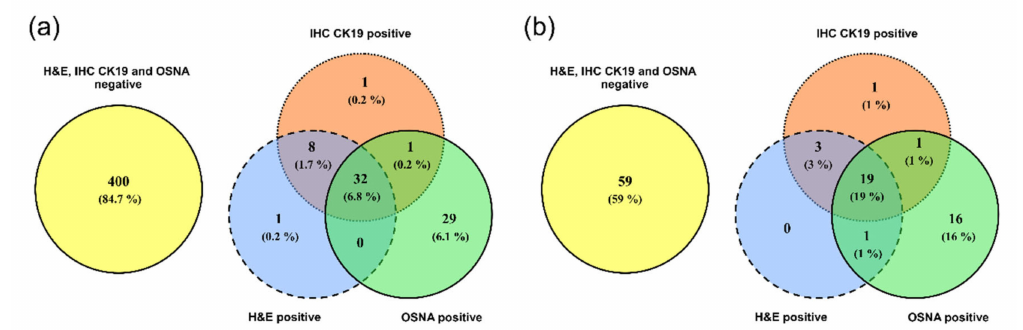
Figure 1. Comparison of examination results for the presence of tumor cells using the H&E, IHC CK19 and OSNA methods by Venn diagrams. ( a ) Groups of lymph nodes; ( b )